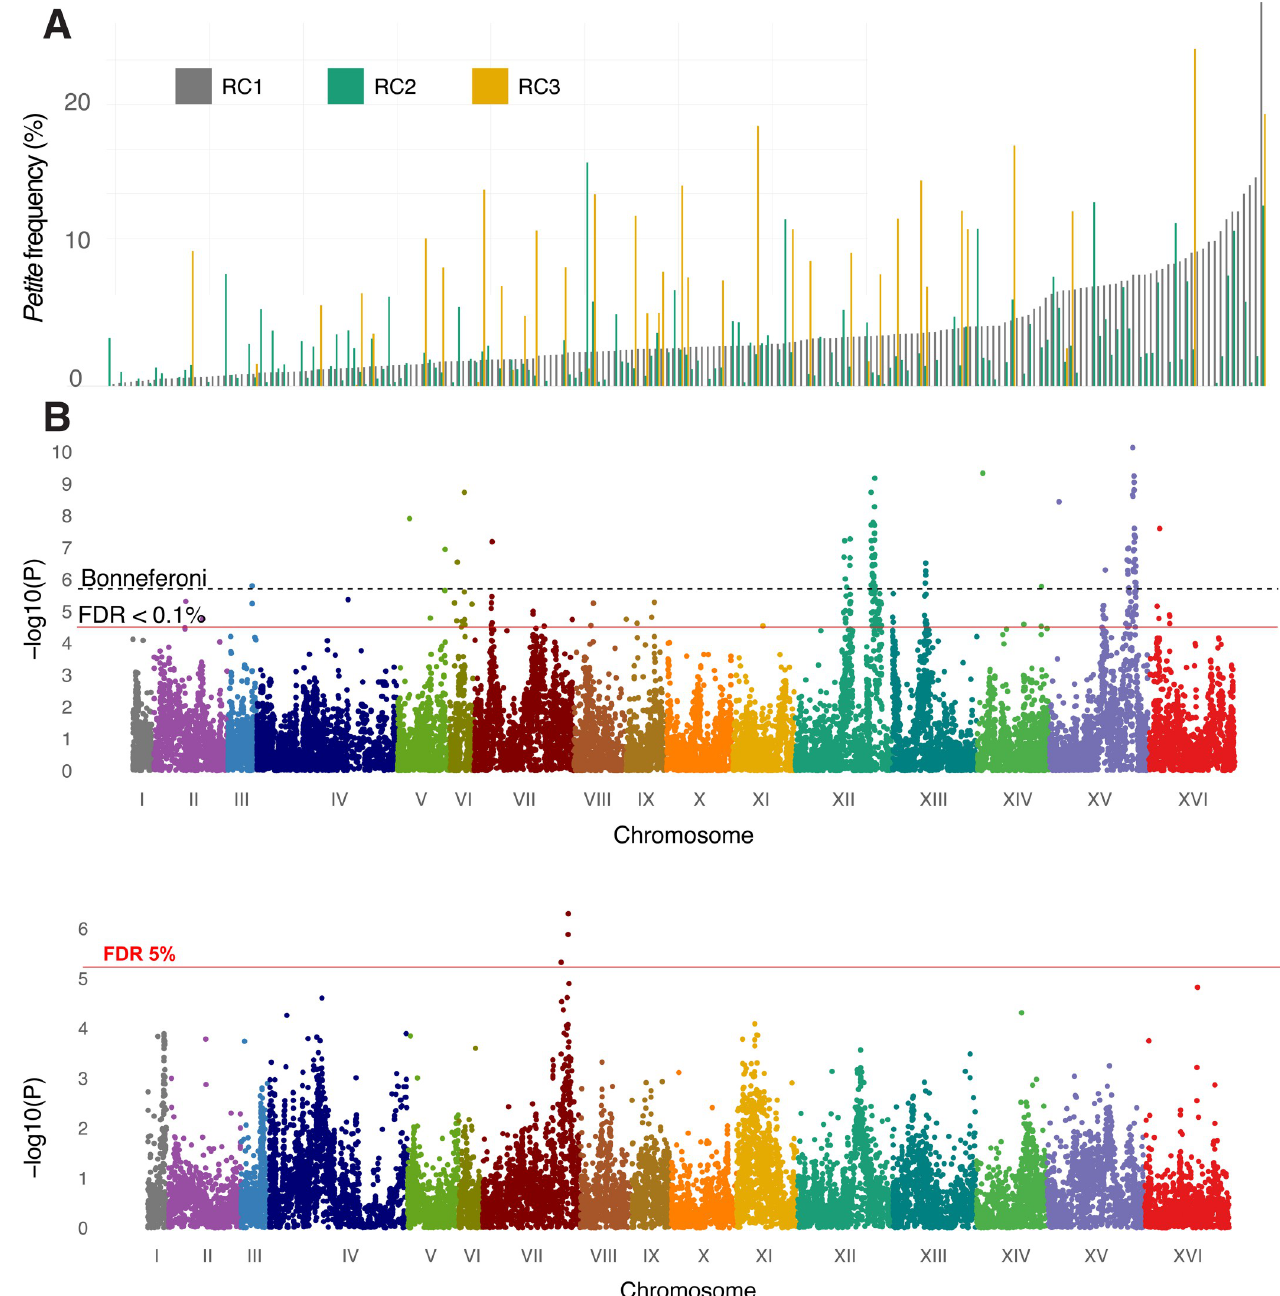
Fig 5. Nuclear SNPs associate with mtDNA stability through main effects and mitonuclear interactions. A . Petite frequency is a quantitative trait influenced by natural genetic variation. Petite frequencies for strains from RC1 (gray) were rank ordered from lowest to highest. The petite frequencies for strains from RC2 (green) and RC3 (gold) are plotted next to isonuclear strains from RC1. B. Manhattan plots show main effect nuclear SNPs associated with petite frequencies in ways that were independent of mtDNA and C. nuclear SNPs whose association is dependent on mitotype (ie. mitonuclear). The different plot profiles indicate that the main effect nuclear SNPs are different that those involved with mitonuclear interactions. FDR thresholds at 0.1% ( P < 4.1 × 10 − 5 ) for nuclear associations and 5.0% ( P < 1.2 × 10 − 5 ) for mitonuclear associations and a conservative Bonferroni threshold ( P < 2.0 × 10 − 6 ) are shown.